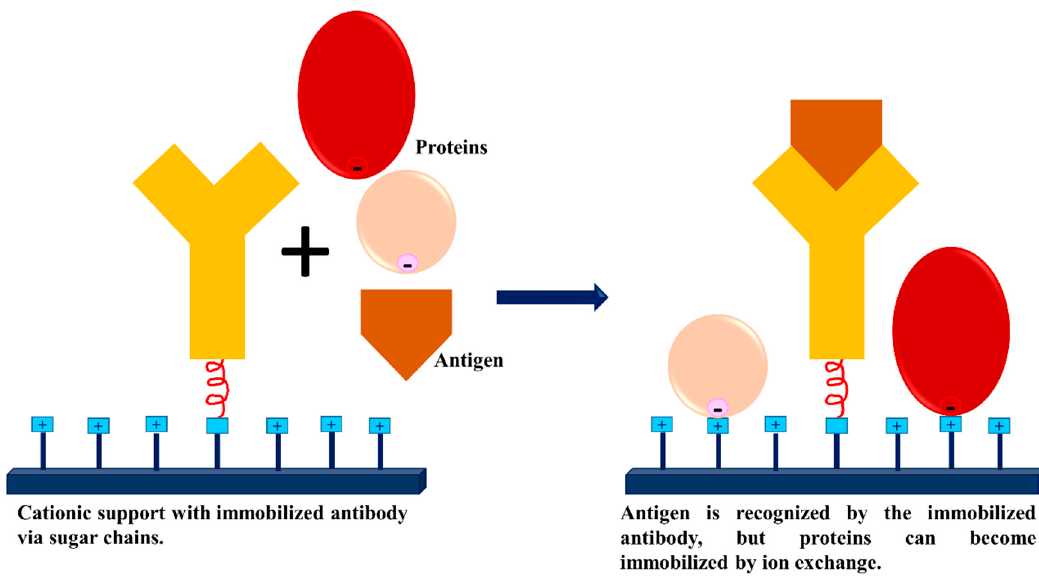
Figure 11. Antibodies immobilized on aminated supports: good functionality by many proteins can become unspecifically adsorbed on the support.